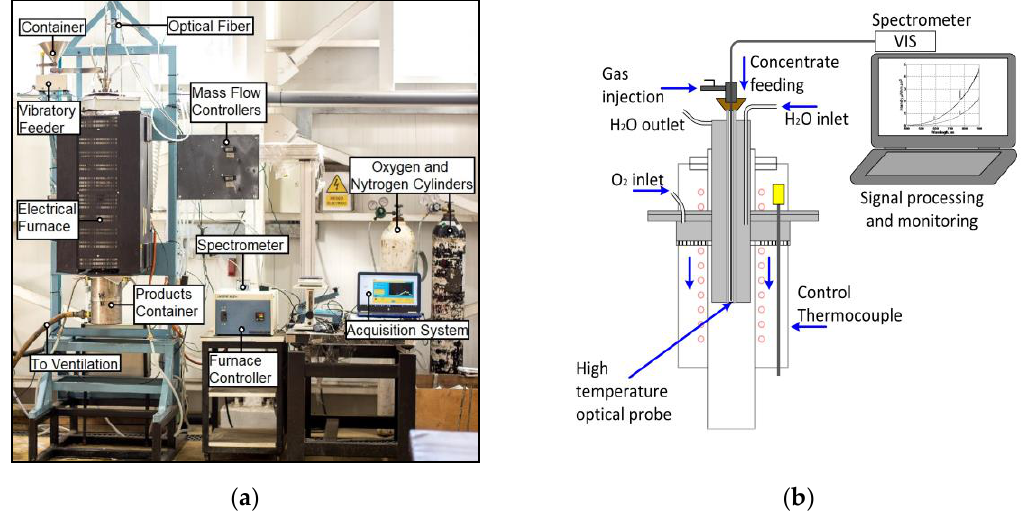
Figure 1. Experimental setup: ( a ) Experimental setup picture depicting main components; ( b ) Optical setup of a constructed pinhole to shaft spectra access.